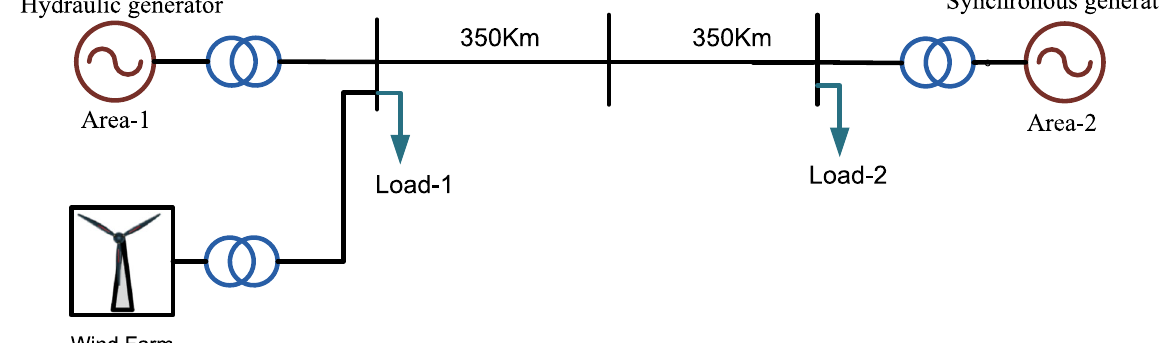
Fig. 1 Modified two-area power system model with wind energy